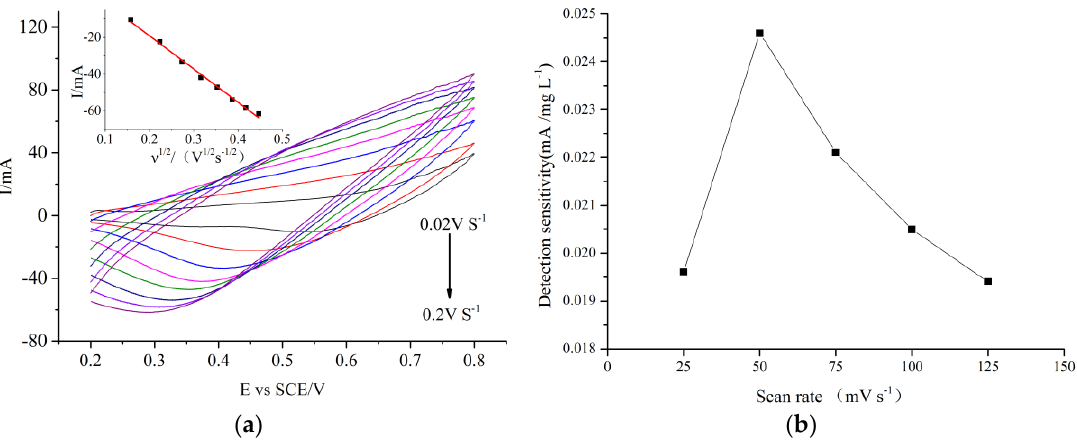
Figure 6. ( a ) CV curves recorded in 0.075 M NaOH solution containing 0.7 mM glucose at different scan rates. Inset is the relationship between peak current and scan rate. ( b ) effect of scan rate on the sensitivity to COD.